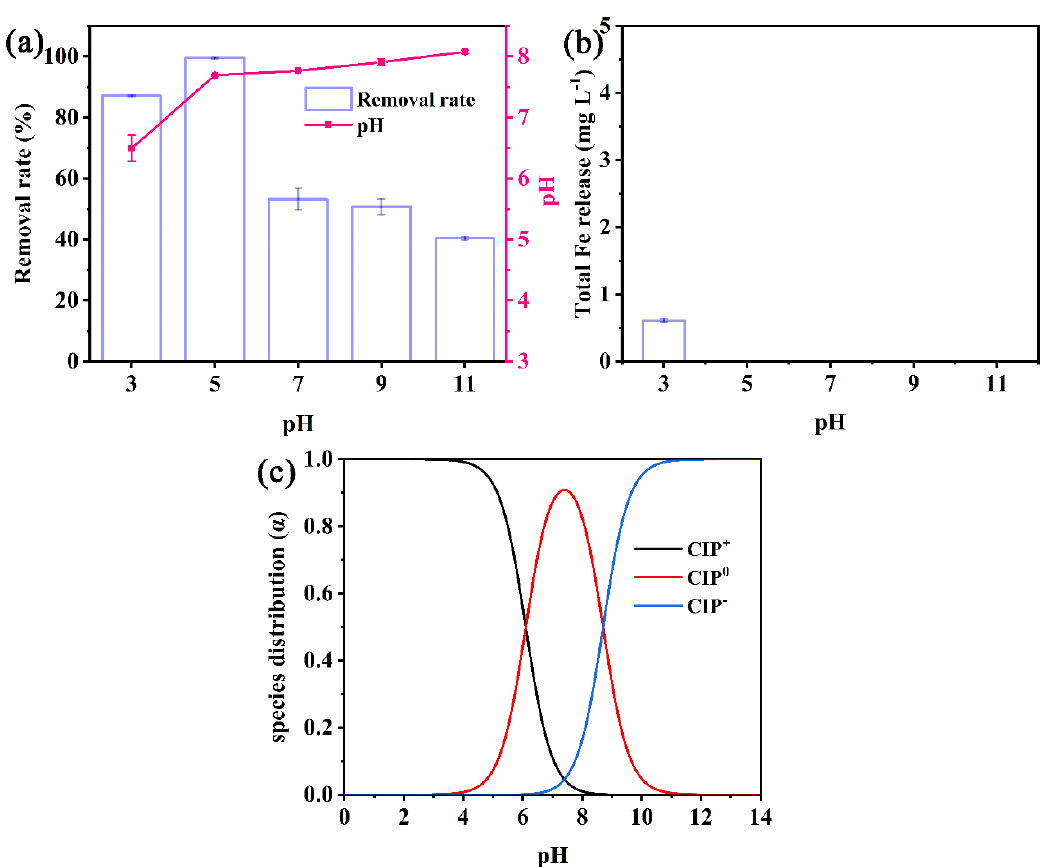
Figure 3. CIP removal efficiency and pH variation ( a ), total Fe release ( b ), and the species of CIP ( c ) in different pH by nZVI/PA composites.